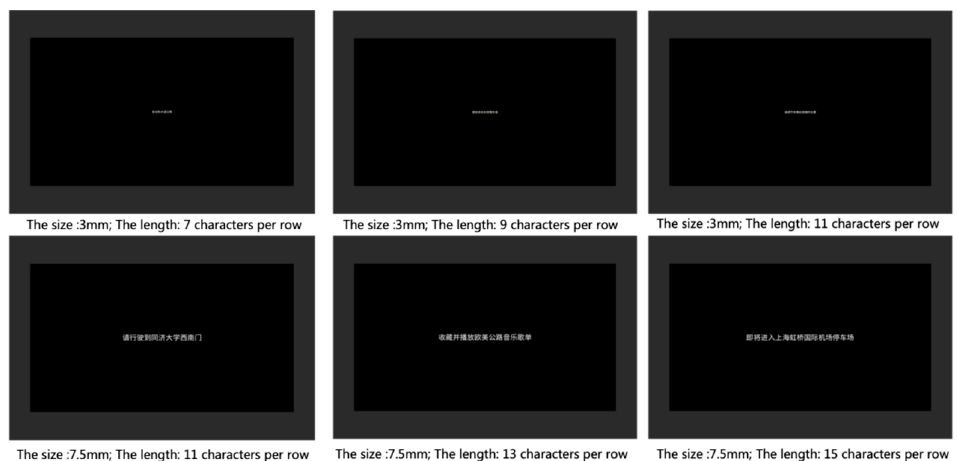
Figure 2. Test content.